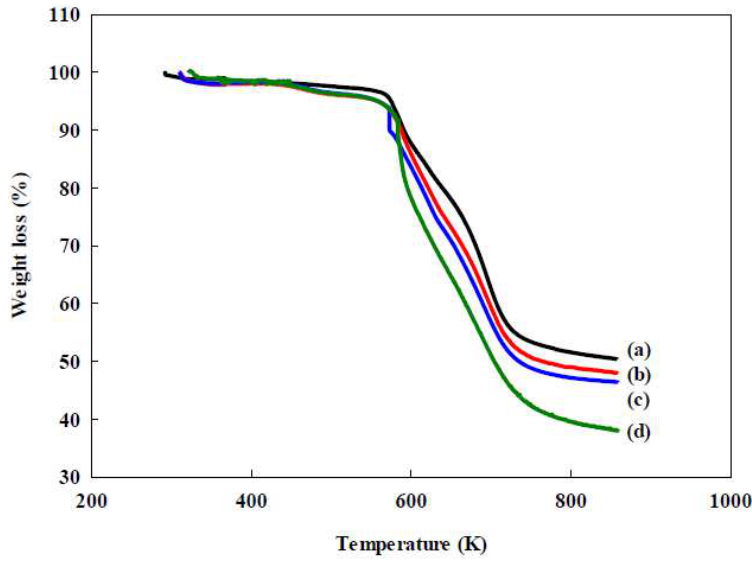
Figure 4. TGA curves of ( a ) PAN, ( b ) P-COOH, ( c ) P-COOH-CS, and ( d )